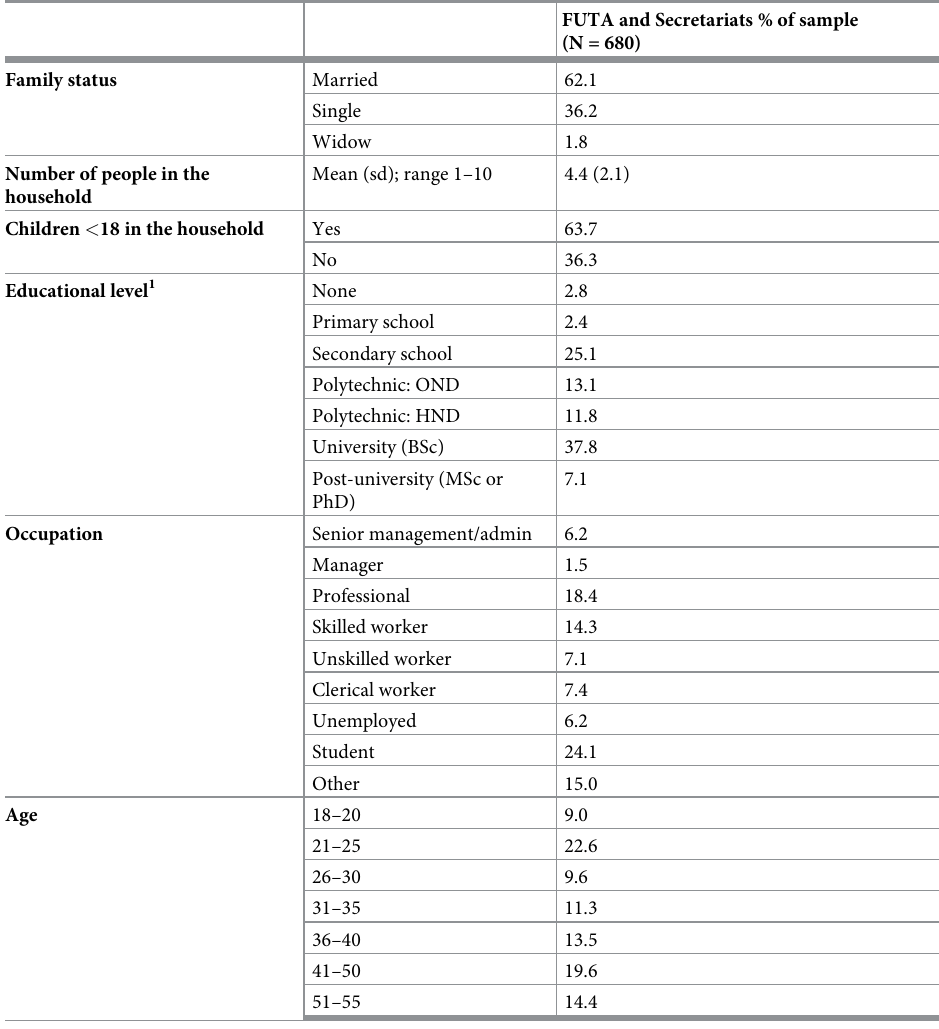
Table 2. Overview socio-demographics study sample of the control study